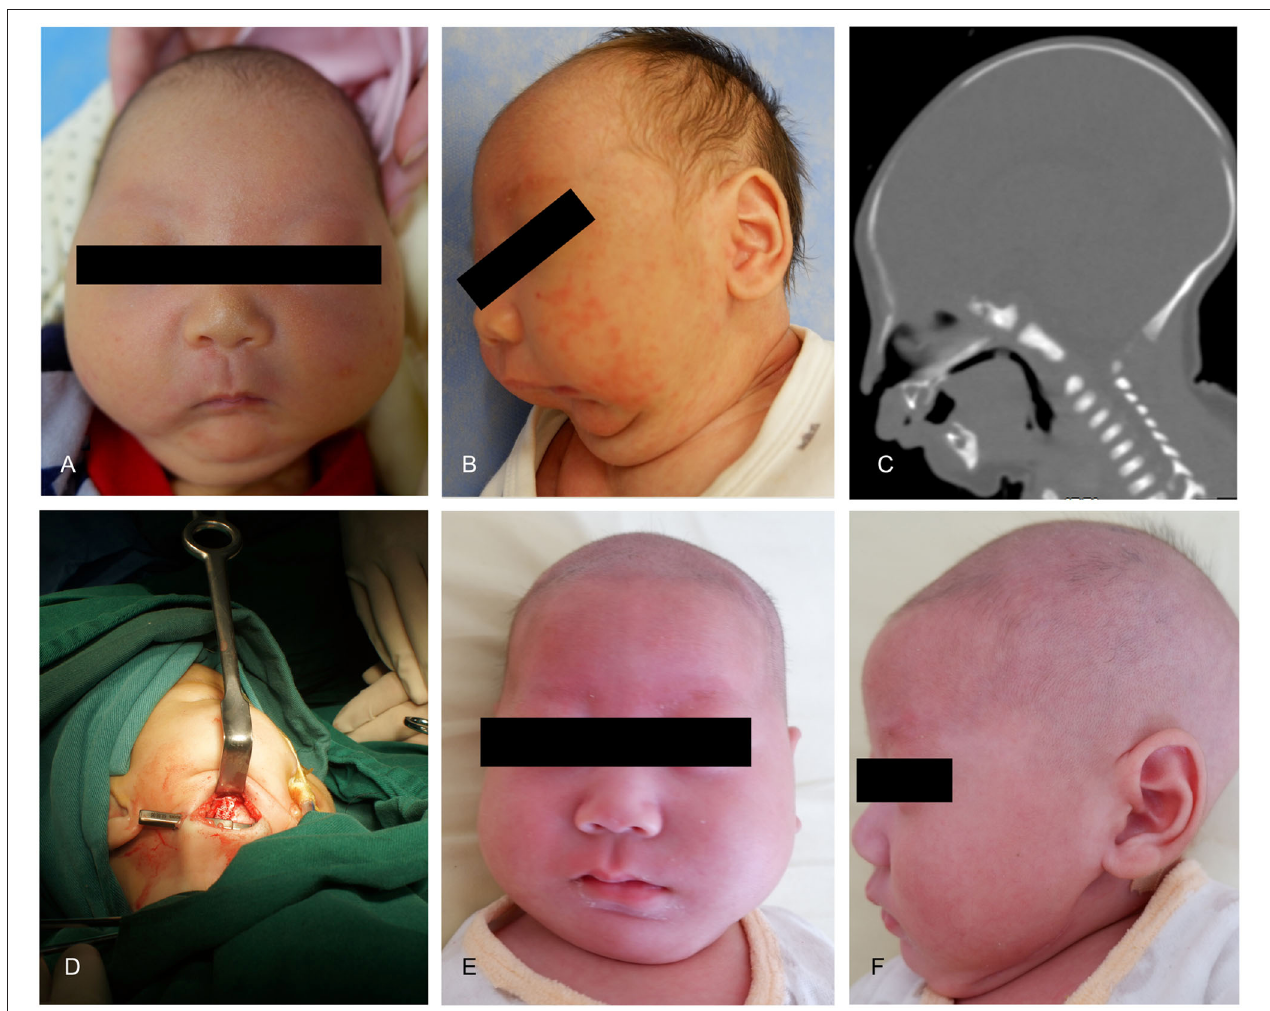
FIGURE 5 | Case 2. (A) A preoperative frontal view. (B) Preoperative lateral view. (C) Preoperative CT-scan. (D) Intraoperative situation. (E) Postoperative anteroposterior view. (F) Postoperative lateral